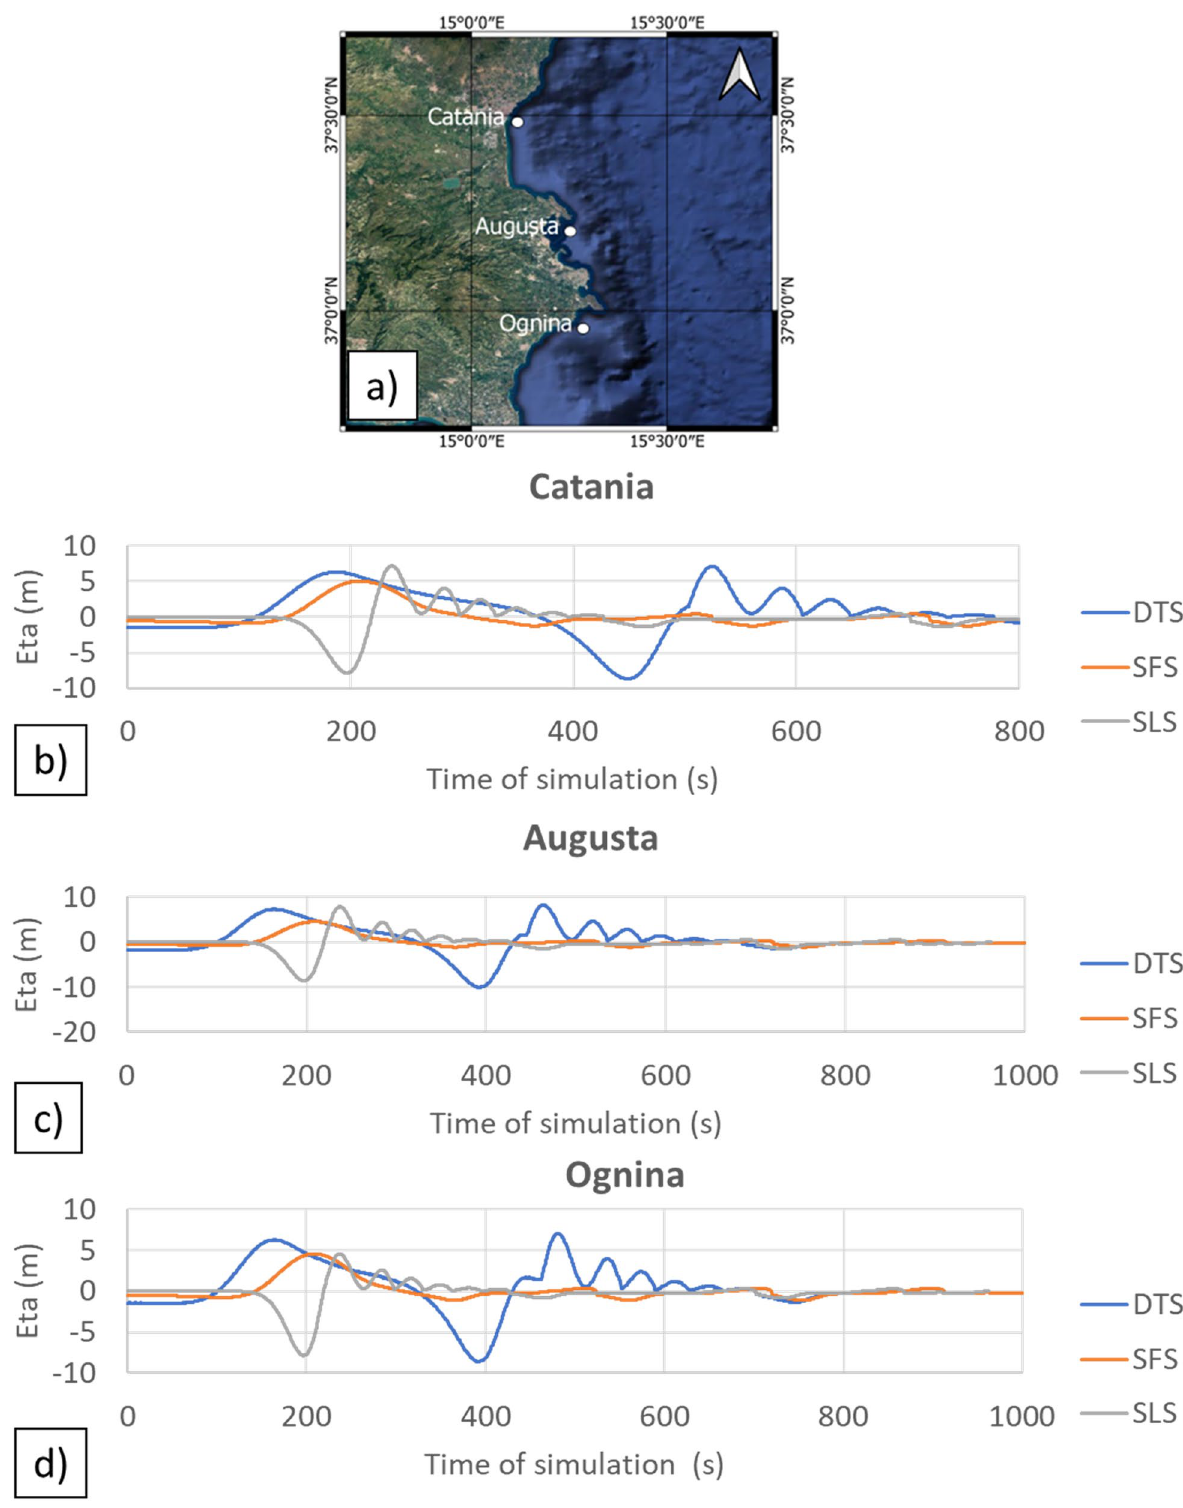
Figure 7. Sea-surface elevations (Eta) for three coastal areas ( a ): Catania, Augusta, and Ognina; the map was obtained by co-authors through QGIS—software (version 3.14.16); https:// www. qgis. org/ it/ site/, license Creative Commons. Attribution-Share Alike 3.0 licence (CC BY-SA) integrated with ESRI World Imagery; ( b ) time- series for Catania; ( c ) time-series for Augusta; ( d ) time-series for Ognina. Each surface elevation was modelled for the three scenarios: DTS, SFS, SLS. The DTS scenario showed the negative trough after the first tsunami wave followed by the second tsunami